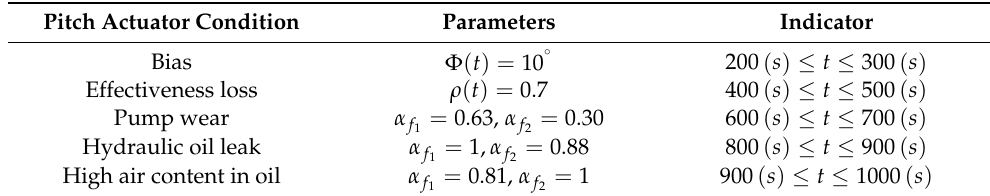
Table 2. Single fault scenario.